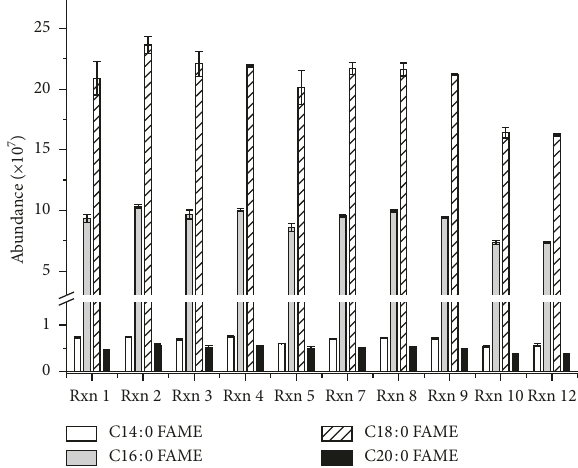
Figure 3: Compositions of fatty acids in methyl-esterified products obtained directly from zinc stearate in various conditions. The areas of each peak were